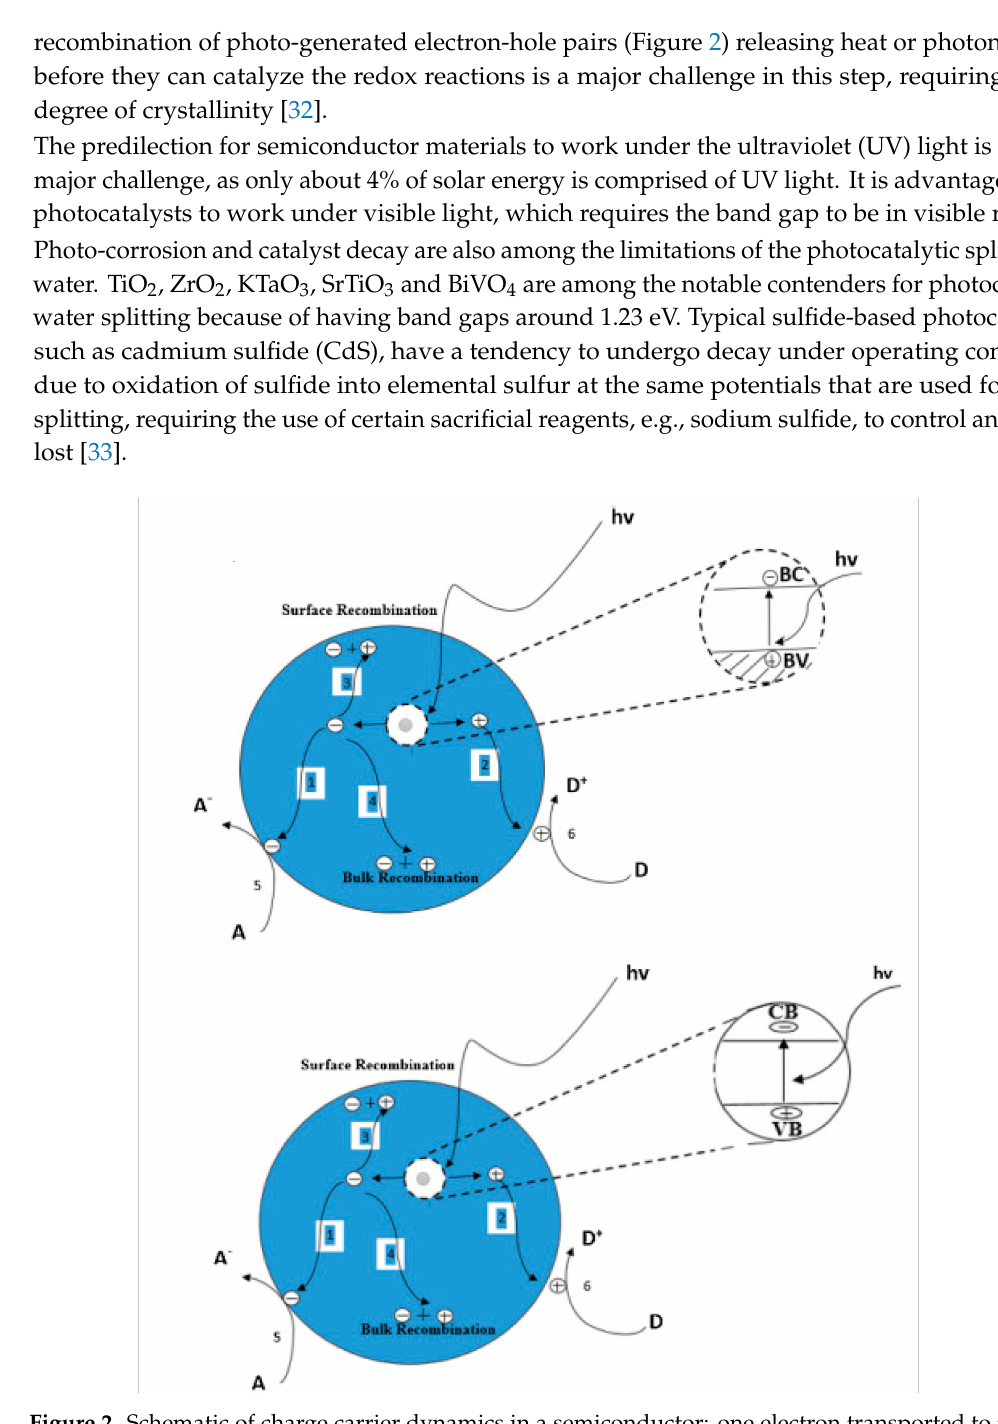
Figure 2. Schematic of charge carrier dynamics in a semiconductor: one electron transported to the surface; two holes transported to the surface; three surface recombinations; four bulk recombinations; five electron transfers to respective acceptor molecules; and six hole trappings by a donor molecule. (Reprinted with permission from [34]. Copyright (2019),